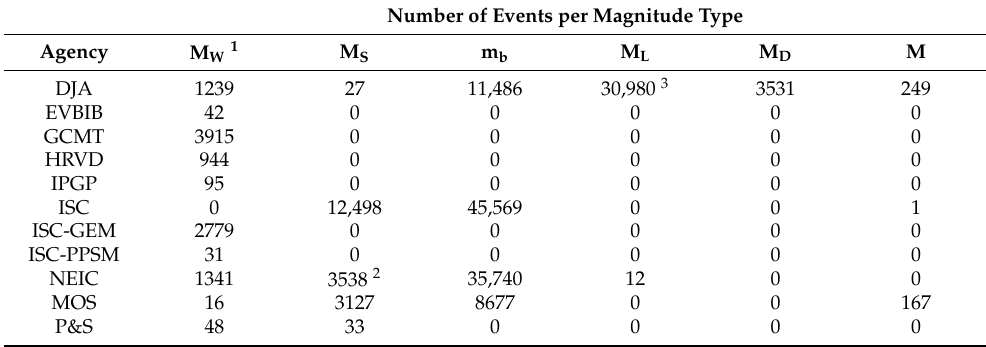
Table 2. Number of earthquakes by seismological agency and magnitude type for Indonesia.